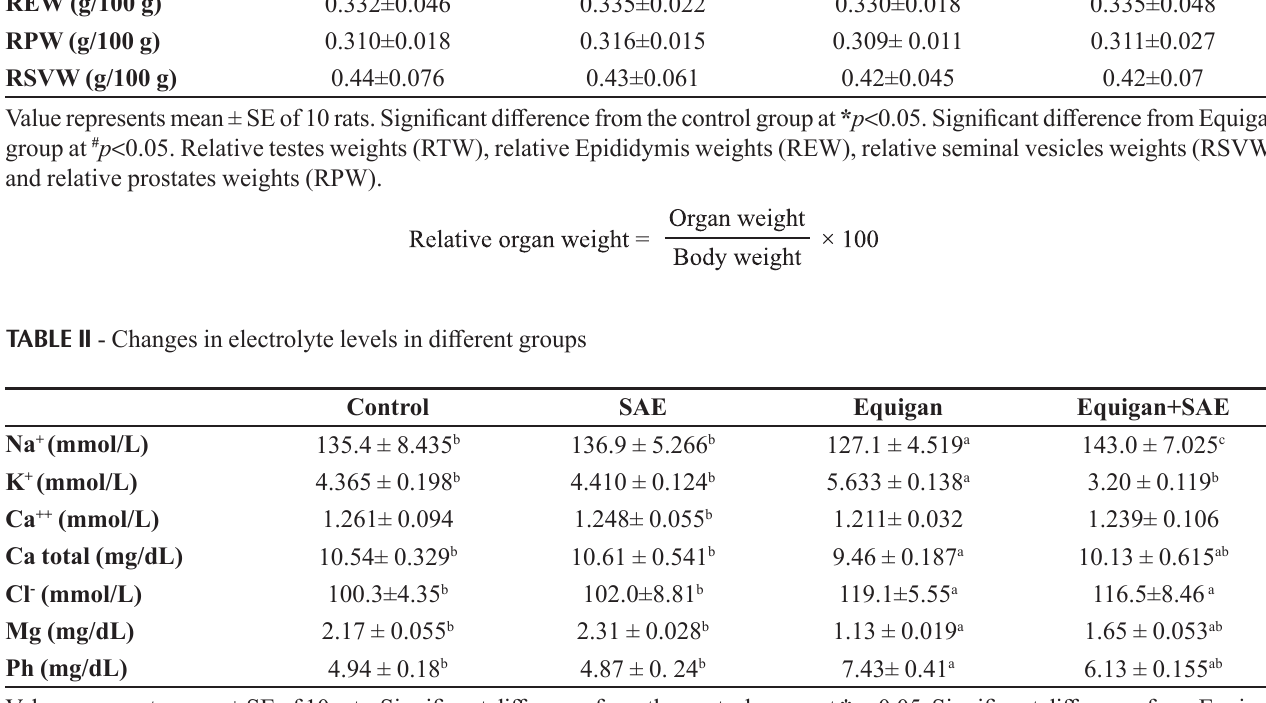
Value represents mean ± SE of 10 rats, Significant difference from the control group at * p < 0.05. Significant difference from Equigan group at # p <